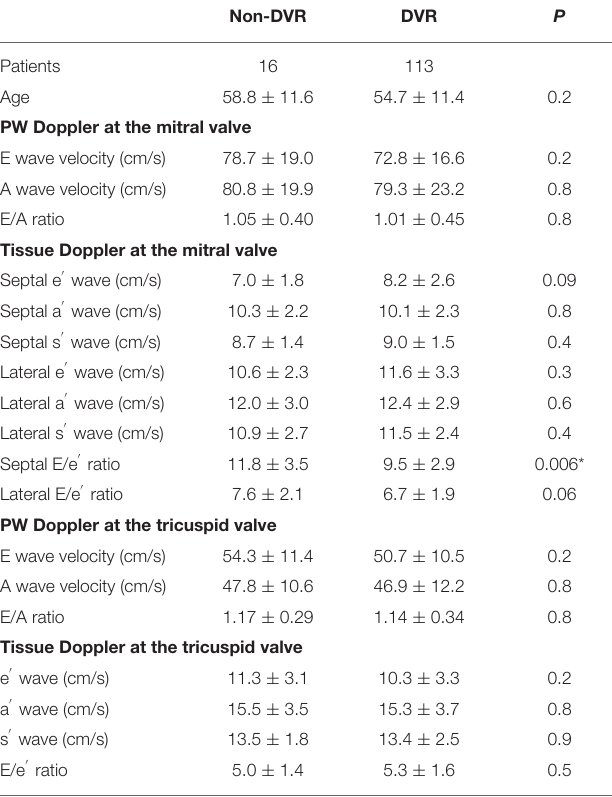
TABLE 4 | Comparison of cardiac Doppler parameters between non-DVR and DVR